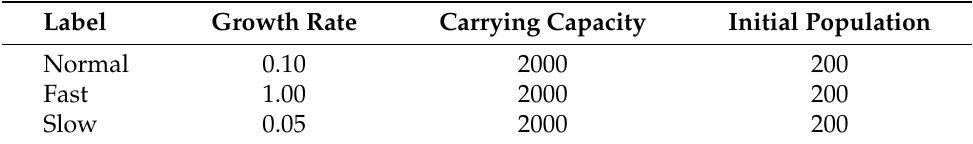
Table 1. Logistic Growth Scenarios.